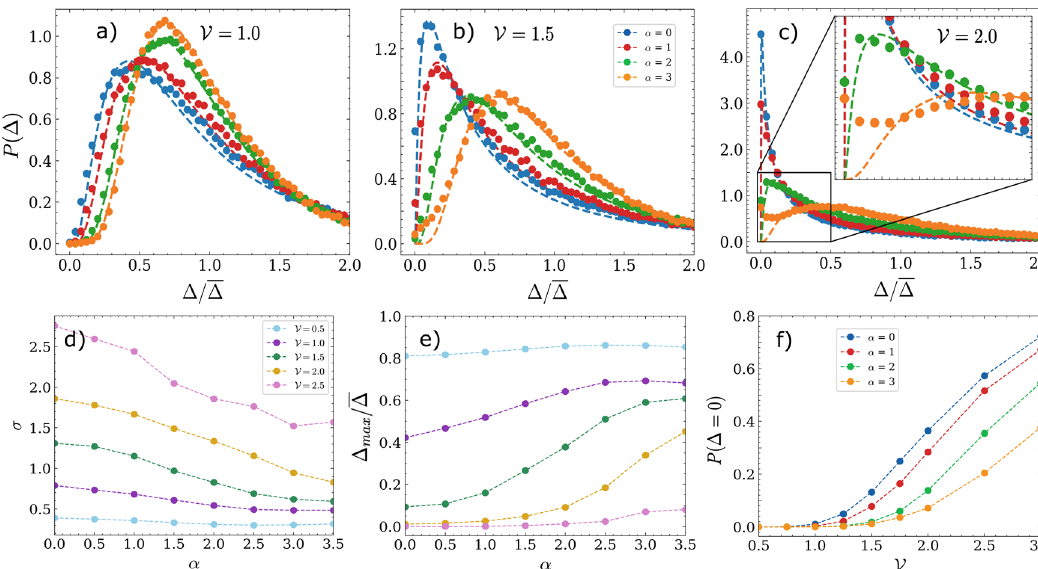
Fig. 3 Statistical properties of the order parameter. Statistical distribution P ( Δ ) of the absolute value Δ of the order parameter, relative to its sample and disorder averaged value (cid:1) Δ , calculated at V ¼ 1 : 0 ( a ), V ¼ 1 : 5 ( b ), V ¼ 2 : 0 ( c ), for a few selected values of α . The dashed lines give the best fi t of the obtained numerical data using the normal-log distribution in Eq. (3). d , e give the α dependence of the distribution width σ and its peak position Δ 0 , obtained in the fi t. f is the probability of zero gap P ð Δ ’ 0 Þð 0 < Δ < 0 : 1 (cid:1) Δ Þ as a function of V . The dashed lines, connecting numerically obtained points in the lower panels, are guides for an